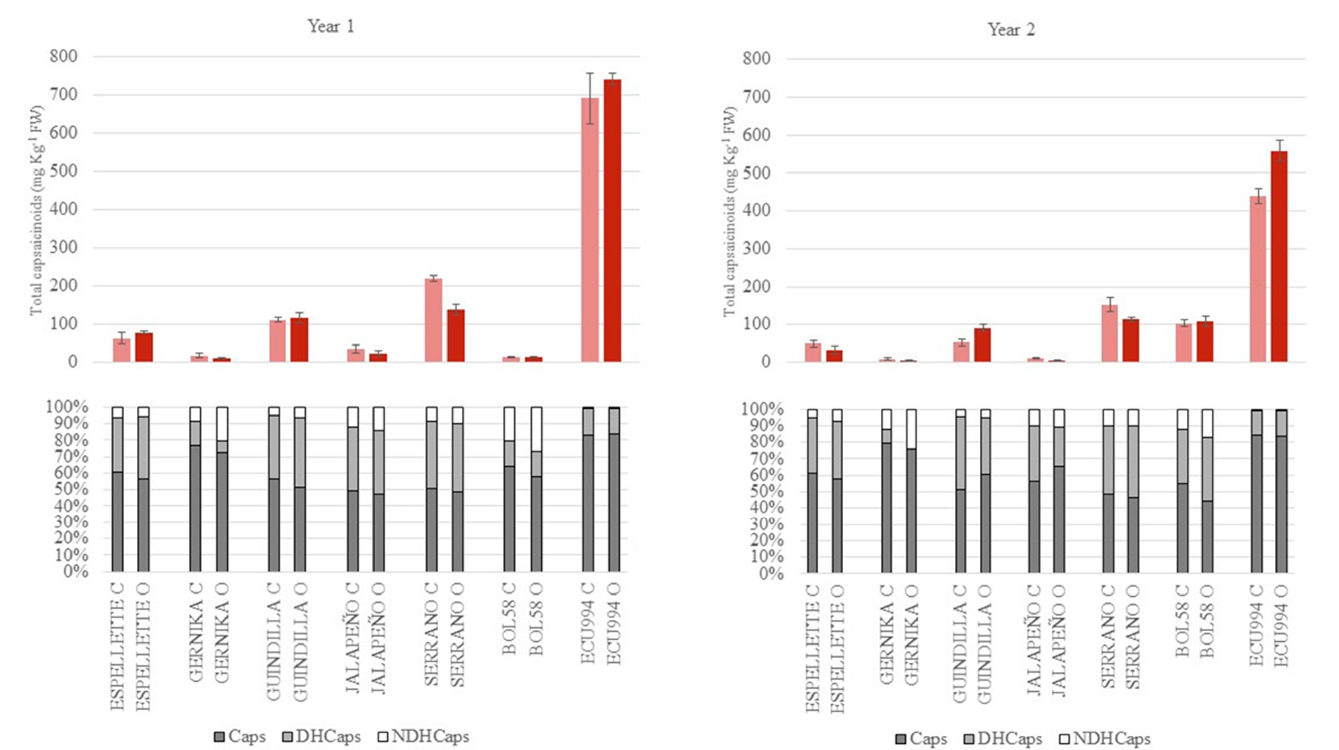
Figure 4. Content of total capsaicinoids (upper, mg kg − 1 of fresh weight) and capsaicinoid profile (lower, % of total capsaicinoids, grey = capsaicin, pale grey = dihydrocapsaicin, and white = nordihydrocapsaicin) at the fully ripe stage for the accessions evaluated under conventional (pale red or C) and organic (red or O) growing conditions in years 1 and 2. Vertical bars in the upper figures indicate SE intervals for each mean value.